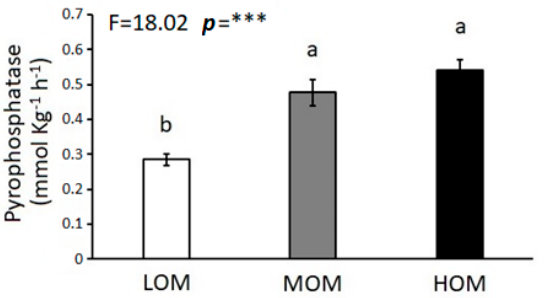
Figure 2. Pyrophosphatase activity ( ± SE) in different soil organic matter contents. Different letters refer to statistically significant differences between treatments, revealed by ANOVA and Fischer LSD test comparisons. (***: p ≤ 0.001).